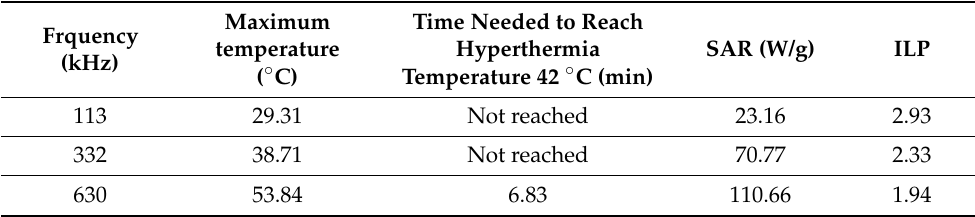
Table 3. Heating characteristics for Fe 3 O 4 MNPs (5 mg/mL) at different frequencies and field amplitudes H 0 = 120